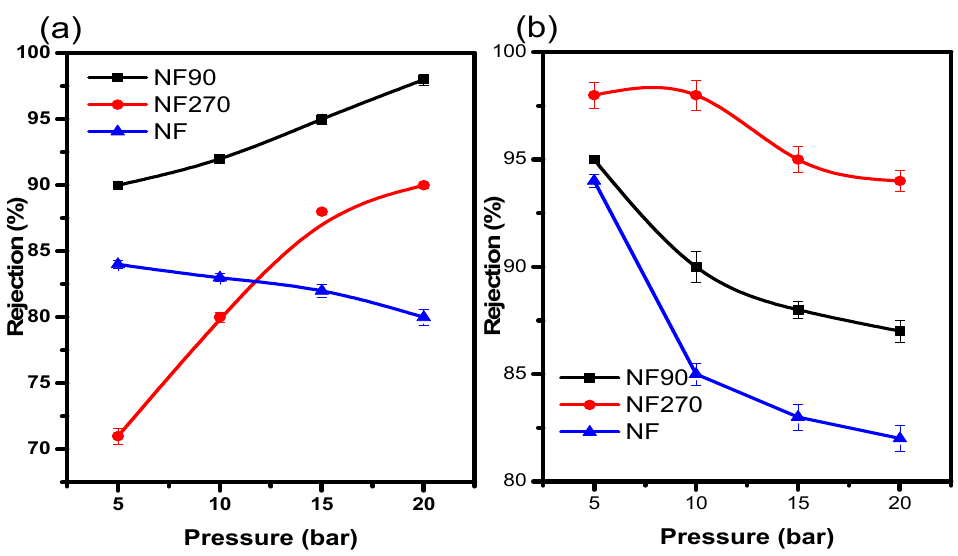
+ and ( b ) Mg 2+ rejection at pH 2.0 and 20 Figure 5. ( a ) Na + and ( b ) Mg 2 + rejection at pH 2.0 and 20 ppm. Figure 5. ( a ) Na